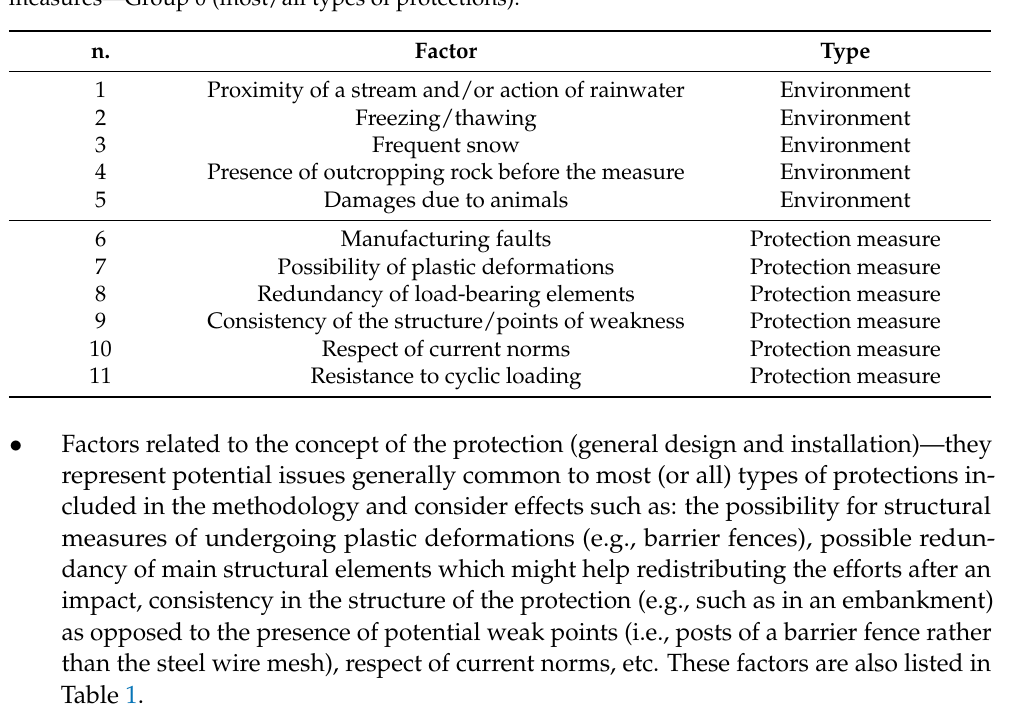
Table 1. List of factors potentially degrading the performance of rock fall protection measures—Group 0 (most/all types of